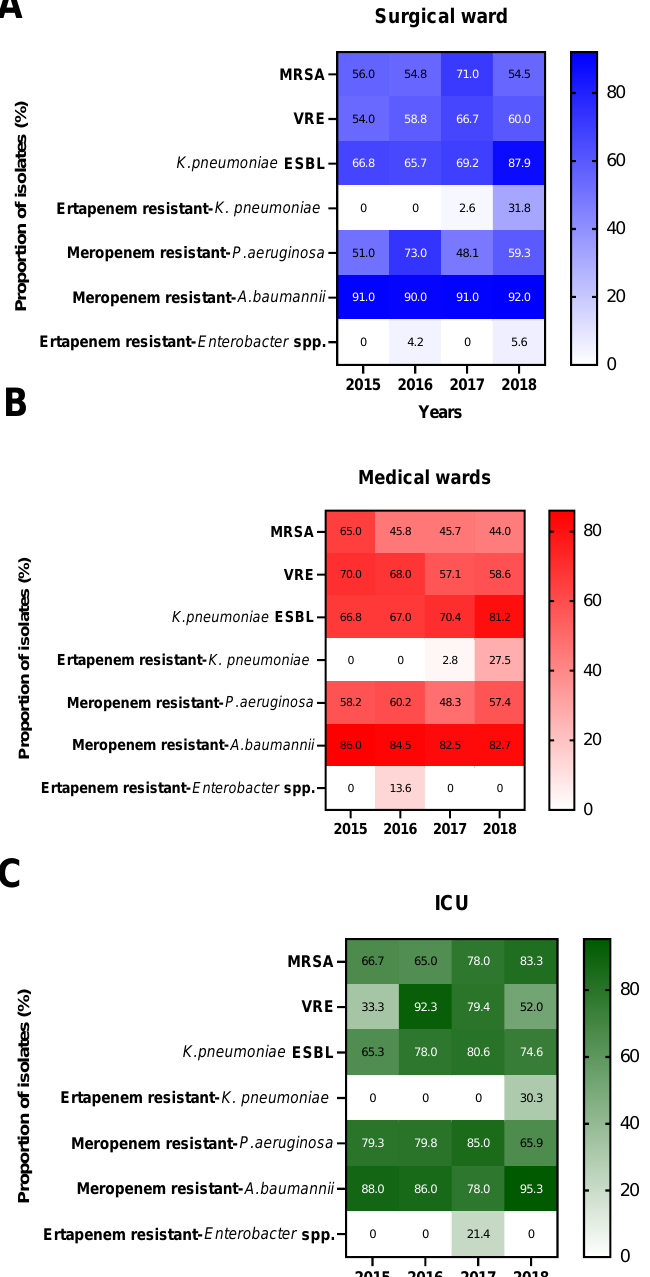
Figure 2. Evolution of the antimicrobial resistance rate of ESKAPE pathogens by hospital areas. ( A ). Surgical ward ( B ). Medical wards ( C ). ICU. Abbreviations: MRSA = methicillin-resistant Staphylococcus aureus , VRE = Vancomycin resistant Enterococcus faecium , ICU = Intensive care unit.